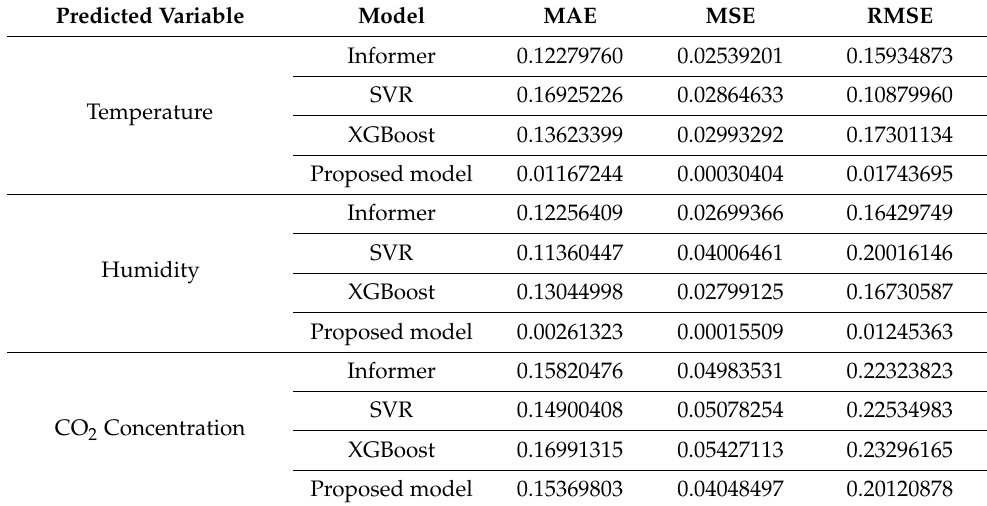
Table 7. The prediction results of two models for the prediction of correlated time